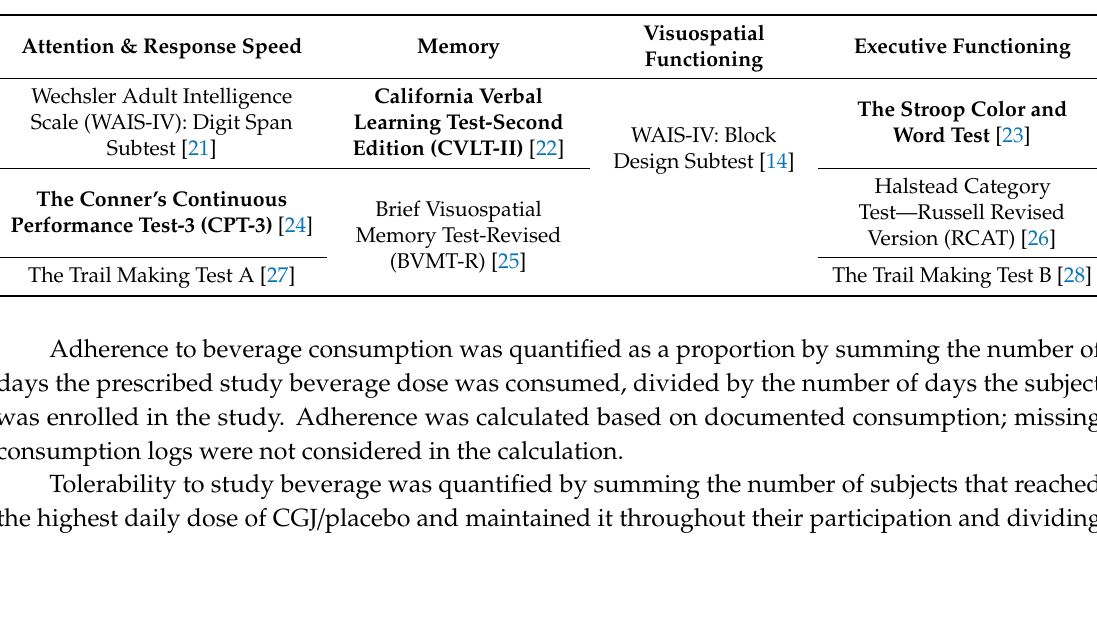
Table 1. Neuropsychological assessments by domain. Note: Three individual neuropsychological measures (bolded) were selected a priori from the literature as most sensitive to cognitive dysfunction in veterans with Gulf War